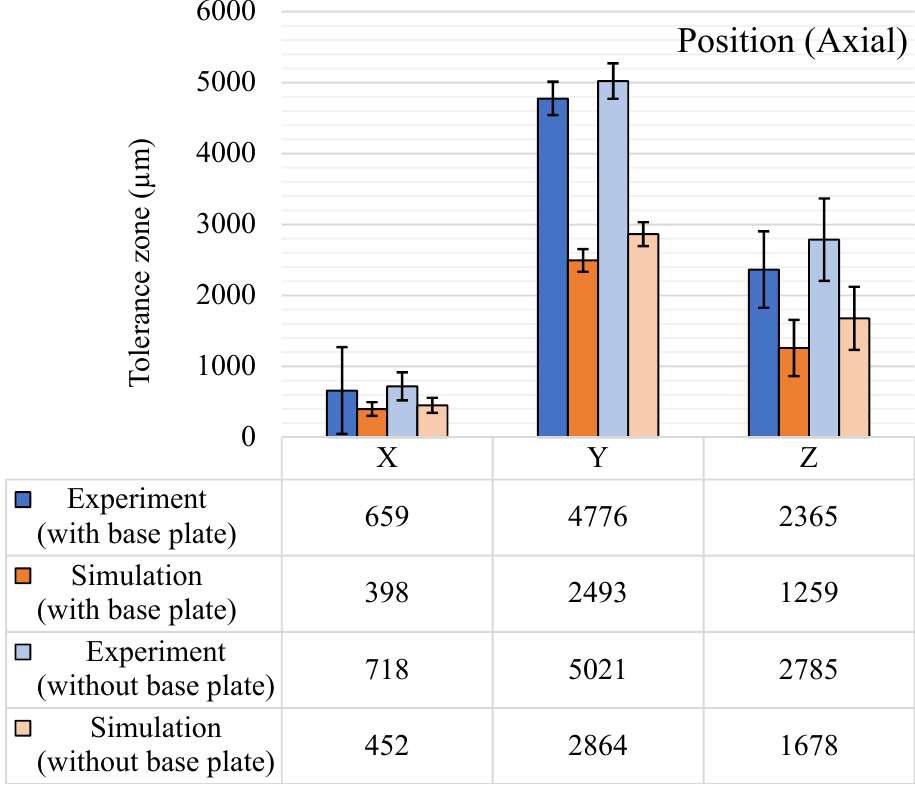
Figure 18. Position tolerance (axial) results (µm), with and without the base plate.